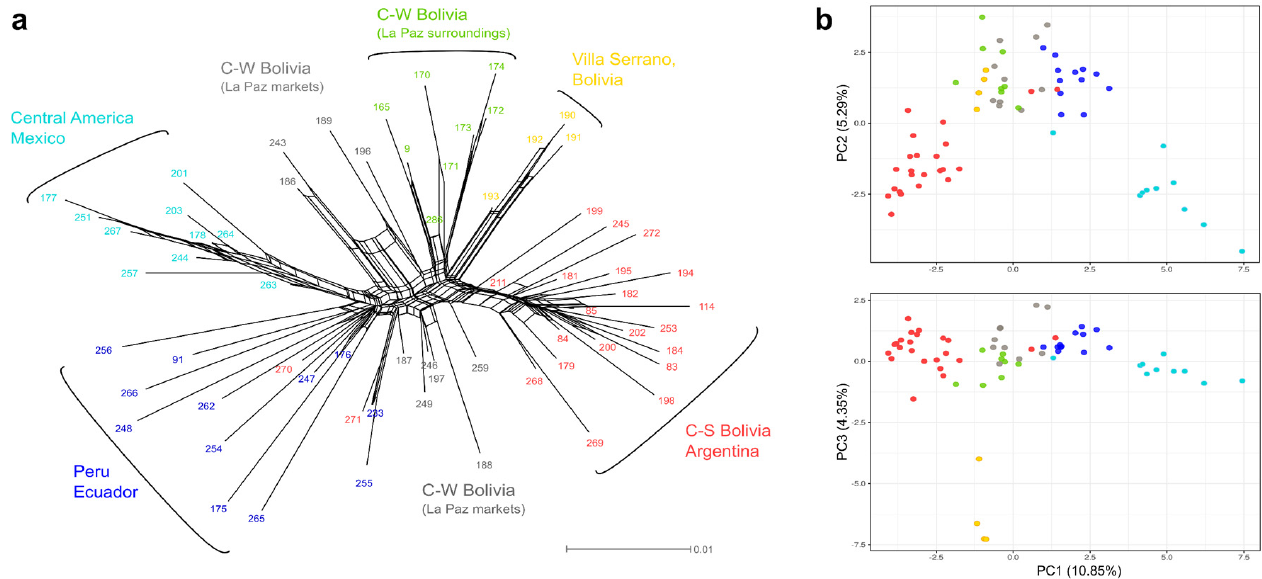
Figure 2. Phylogenetic network and Principal component analyses of 67 C. pubescens samples using 41,636 unlinked SNPs markers. ( a ) Neighbor-Net constructed by SplitsTree. The five genetic groups identified are shown. Samples are labelled with different colours according to their origin/country. ( b ) Principal component analysis (PCA). Axes are labelled with the percentage of variation explained by the two PCs (PC 1 vs. 2 and PC 1 vs. 3). Samples/dots are coloured according to phylogenetic network